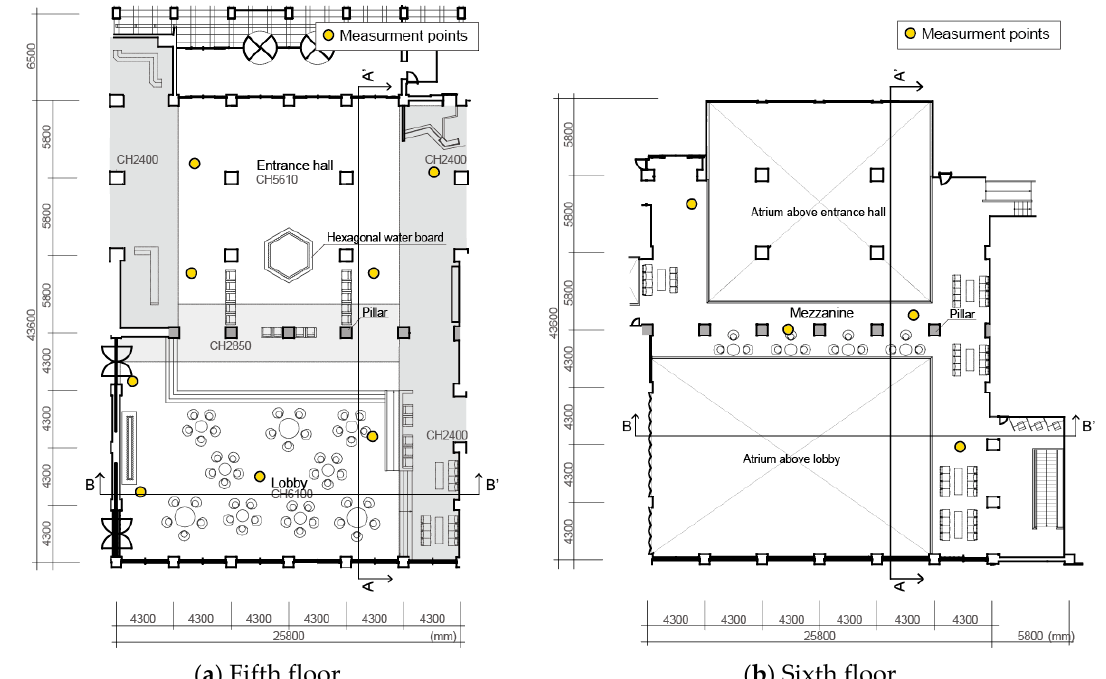
Figure 2. Measurement points on the ( a ) fifth floor and ( b ) sixth floor of the measurement item of No.1 in Table 1.